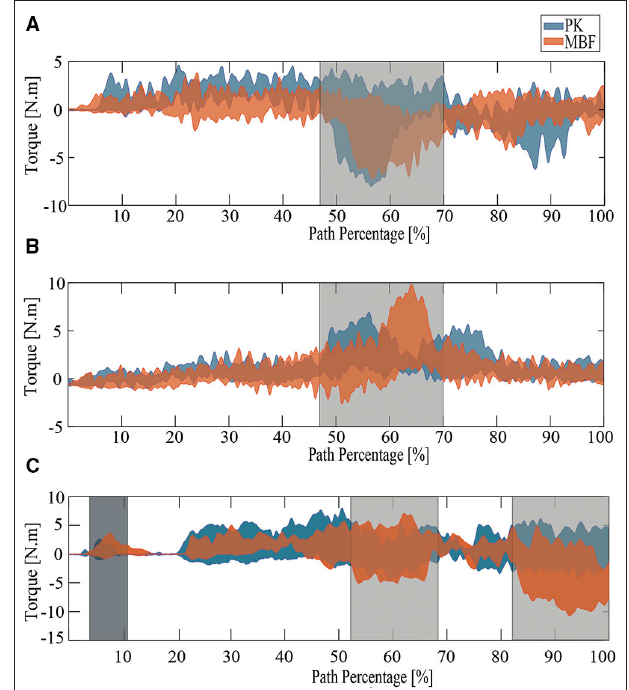
FIGURE 9 | The behavior of the results obtained for torque. PK stands for older adults with PD and MJF stands for a group of older adults with base, joint, and fracture diseases. The areas highlighted in gray represent the times when the turns were presented and the area highlighted in black represents the time when the subjects were leaning on the device to stand up and initiate the test. (A) RUT. (B) RDT. (C)